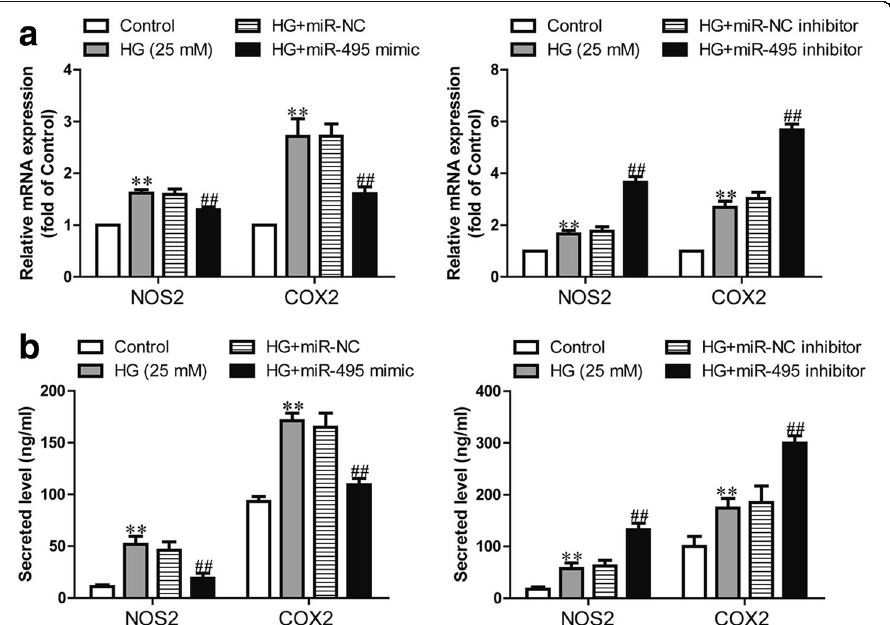
Fig. 2 Effects of miR-495 on pro-inflammatory cytokines in human CFs incubated in high glucose. CFs were transfected with miR-495 inhibitor or mimic for 48 h, and then treated with 5.5 or 25 mM glucose for 24 h. HG + miR-NC indicates CFs transfected with the miR-495 inhibitor before treatment with high glucose; HG + miR-495 mimic indicates CFs transfected with the miR-495 mimic before treatment with high glucose. a The mRNA expressions of NOS2 and COX2 were determined via quantitative RT-PCR. b The secreted NOS2 and COX2 proteins in the supernatants of CFs were detected using ELISA assays. The data shown are means ± SEM ( n = 4). ** p < 0.01 vs. control; ## p < 0.01 vs. vehicle + high glucose. The vehicle is transfection reagent